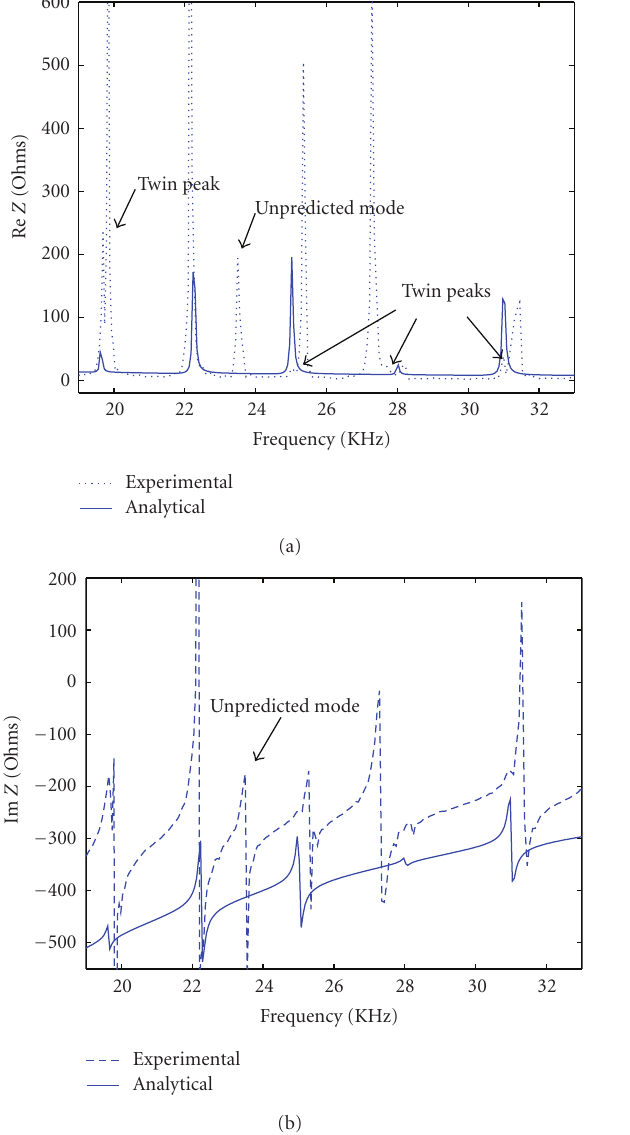
Figure 5: Experimental and analytical impedance spectra for a steel beam.